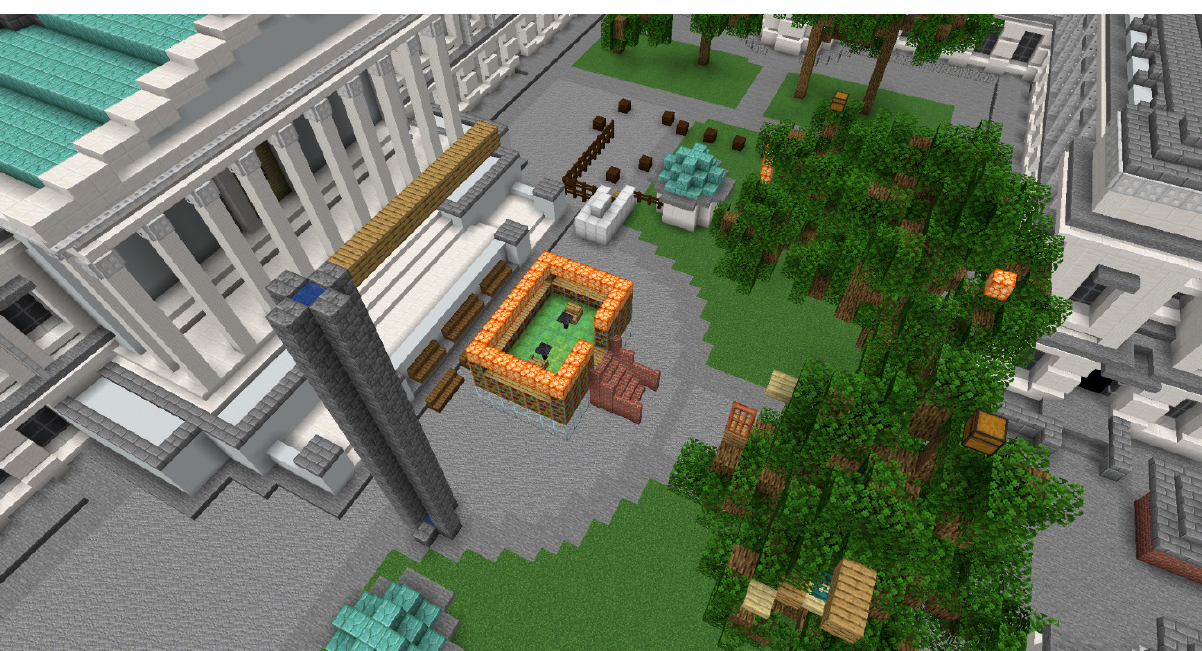
Figure 7. Minecraft plot by kennc05: Trampoline and assault course.